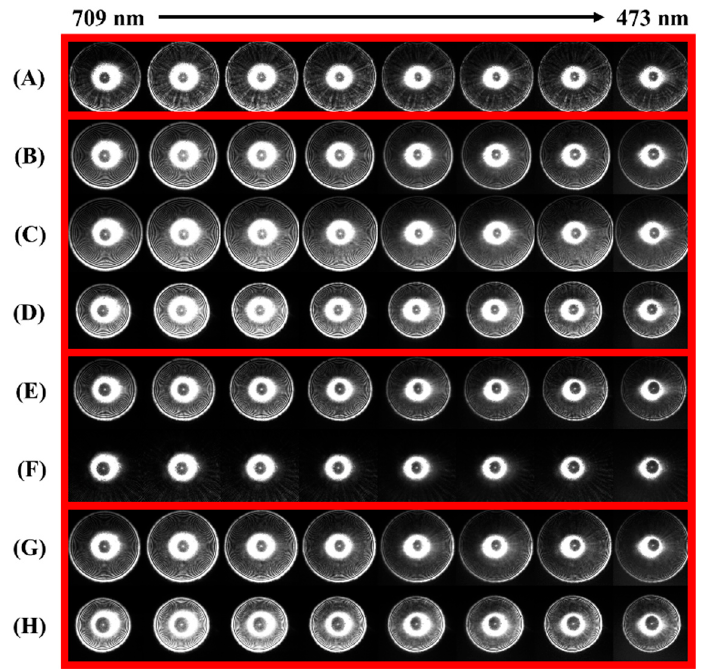
Figure 3. Representative images of the hyperspectral ELS patterns of the eight bacterial